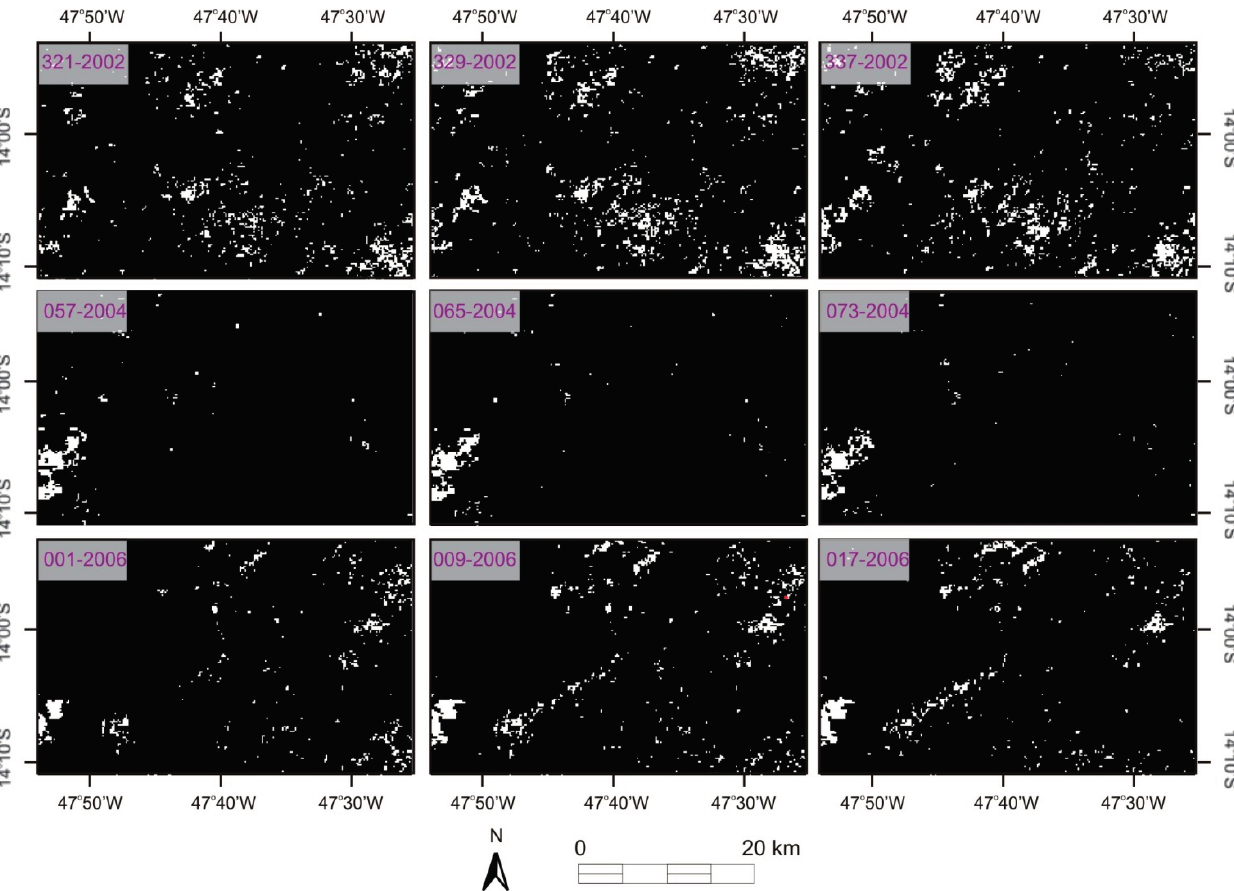
Figure 23. Detection of burned areas using the standardized time series (green line). Threshold line is the black line. Fire events (FE) and false positive (FP) are marked on the bottom of the chart.